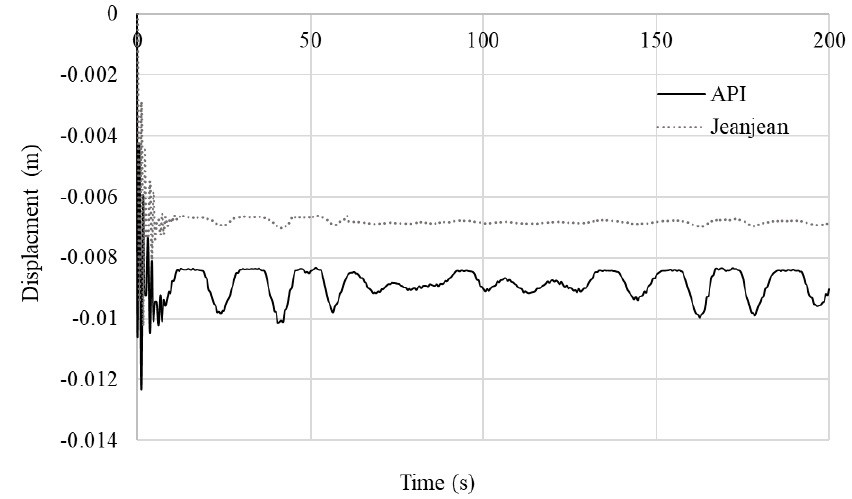
Figure 24. Comparison of the displacements in the z-direction of the jacket foundation resulting from two methods of nonlinear soil stiffness models.